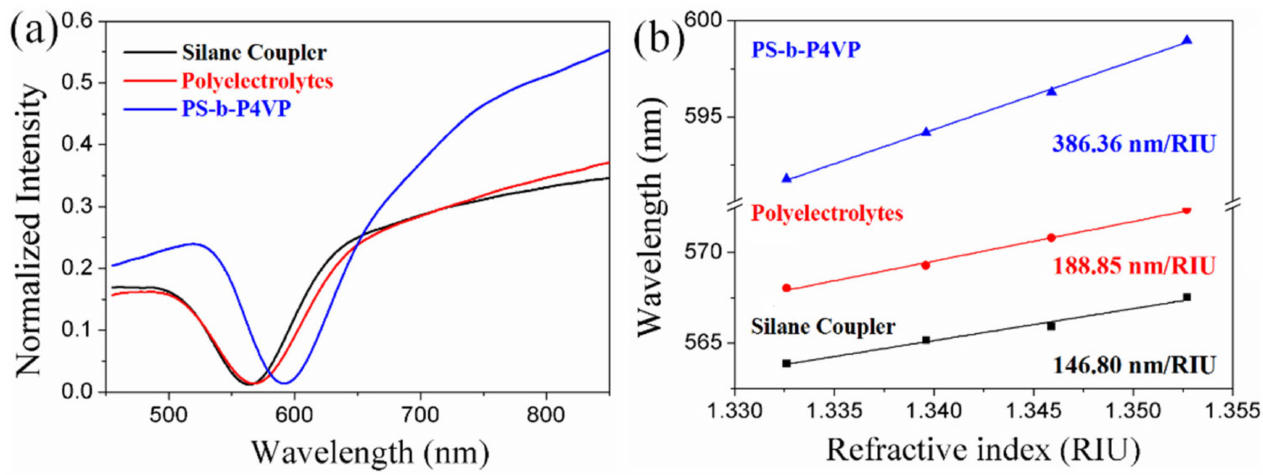
Figure 4. Comparison of ( a ) the LSPR spectra and ( b ) refractive index sensitivity of the sensors which were prepared by silane coupler, polyelectrolytes and BCP